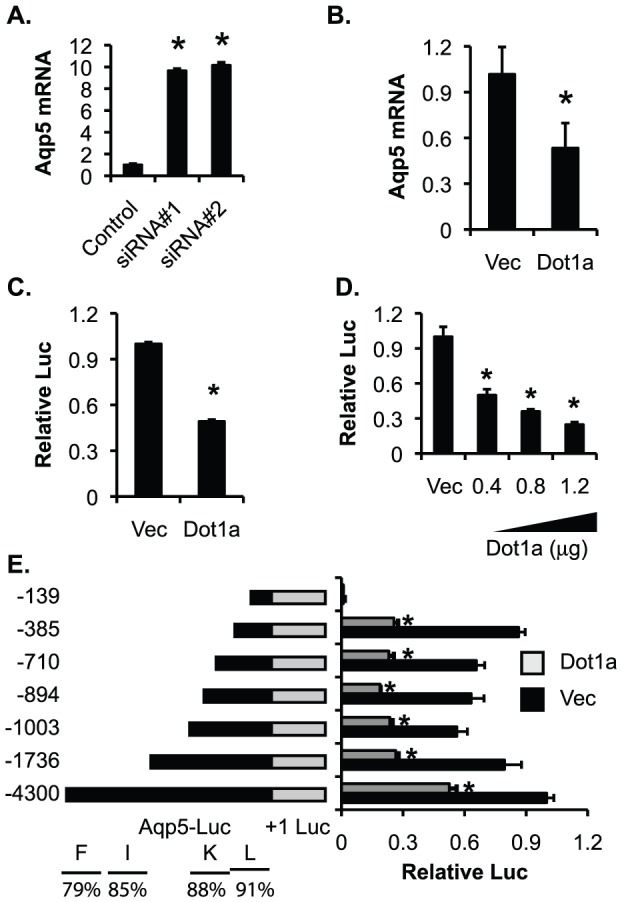
Dot1a represses Aqp5 mRNA expression in mouse cortical collecting duct M1 and mouse lung epithelial MLE-15 cells.(A–B) Real-time RT-qPCR showing that siRNA-mediated depletion of Dot1la in M1 cells increases endogenous Aqp5 expression (A) and that overexpression of Dot1a decreases endogenous Aqp5 expression in MLE-15 cells (B). (C) Luciferase assays showing that overexpression of Dot1a reduces expression of a luciferase reporter driven by a 4.3-kb (−4300 in E) promoter of rat Aqp5 in MLE-15 cells. (D) As in C, except that various amounts of Dot1a plasmid were used for transfection. (E) Luciferase assay showing that Dot1a represses Aqp5 promoter-luciferase constructs as indicated. The relative positions of the Dot1l- and H3m2K79-binding subregions of mouse Aqp5 in ChIP assays were shown at the bottom. The percentages of identities between rat and mouse were also indicated. Note: Dot1a-mediated repression was eliminated in the −139 construct.